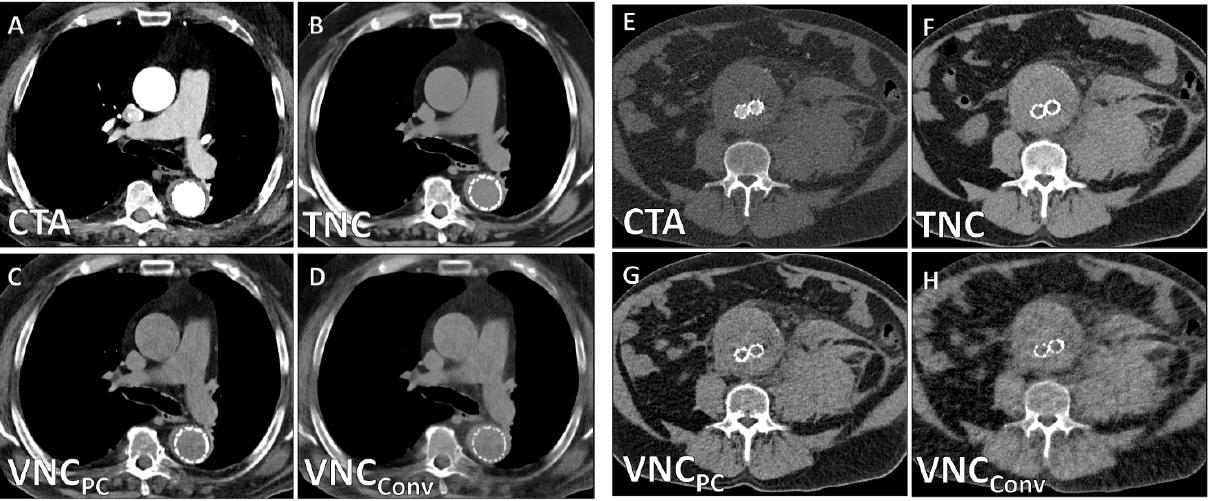
Figure 1. Representative PCD-CT images of a 72-year-old male patient after thoracic EVAR ( A – D ) and a 67-year-old male patient after abdominal EVAR ( E – H ).